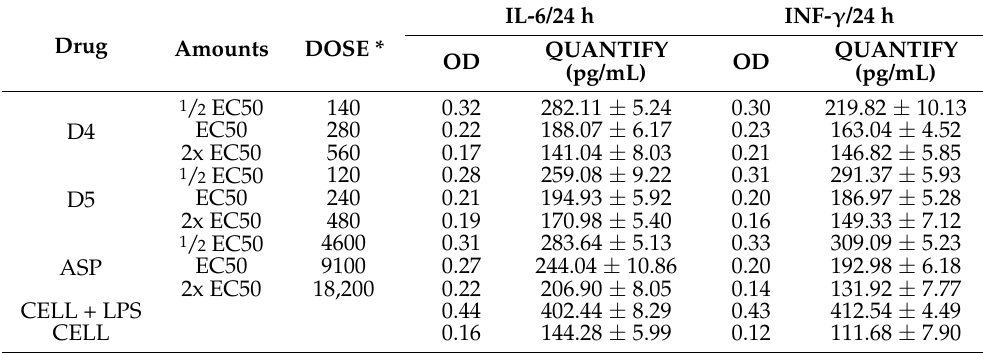
Table 1. Dose selection based on theoretical EC50, 1 / 2 EC50, and 2x